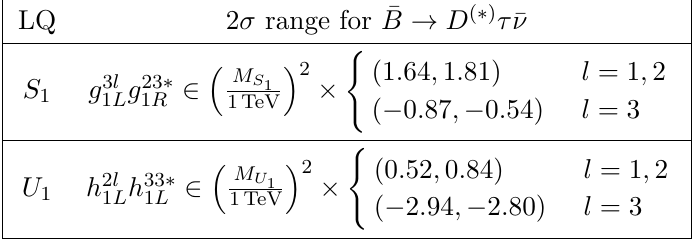
Table 1 . Parameter ranges we utilize in numerical calculations, taken from table.II of [110]. For simplicity, we assume all parameters are real in our